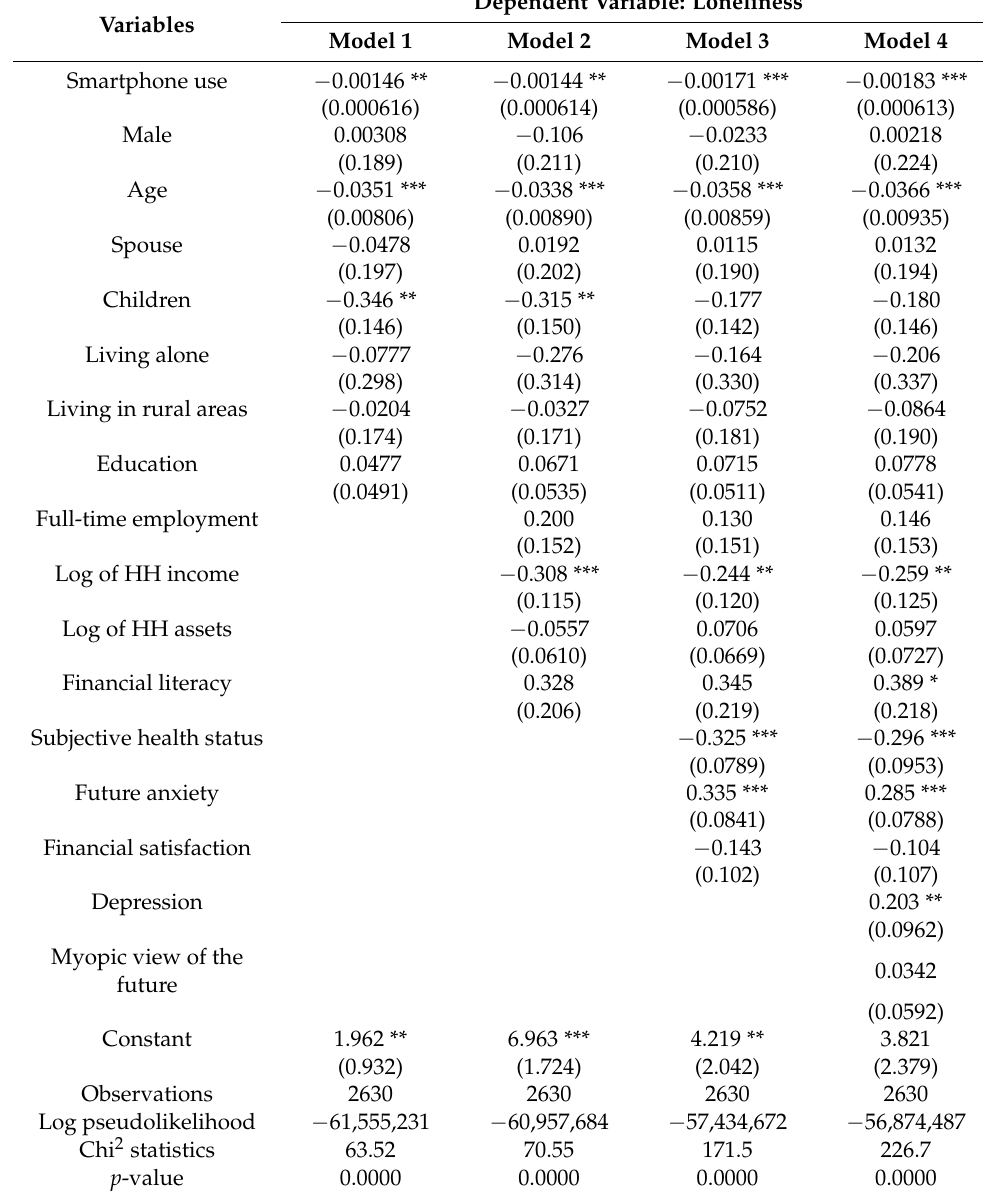
Table 4. Logit regression results of loneliness in